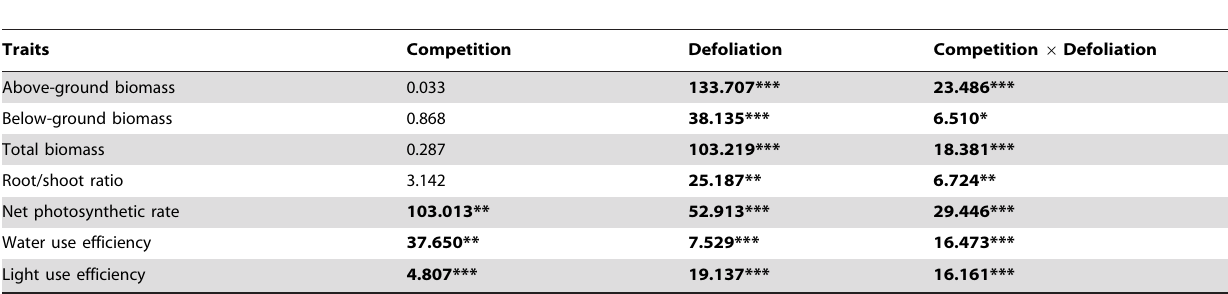
Table 1. F values of the two-way ANOVAs for testing the effects of defoliation (different intensities) and competition (with or without) on the growth and physiological traits of Mikania